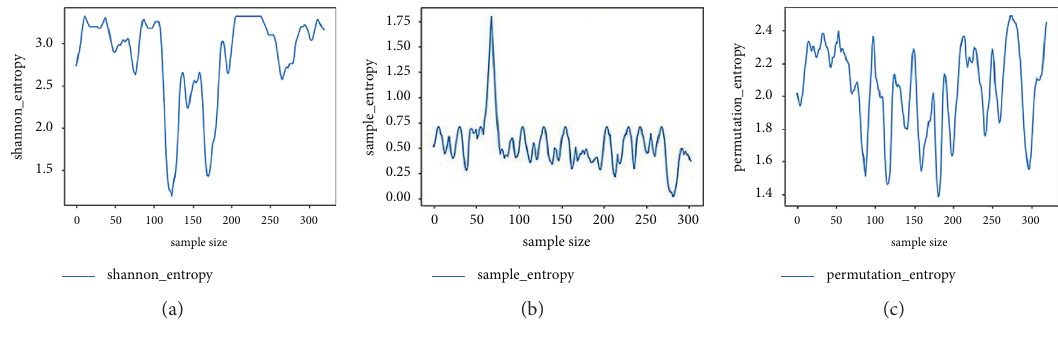
Figure 7: Comparison of entropy of different time series. Table 4: Statistical characteristics of different entropy series.